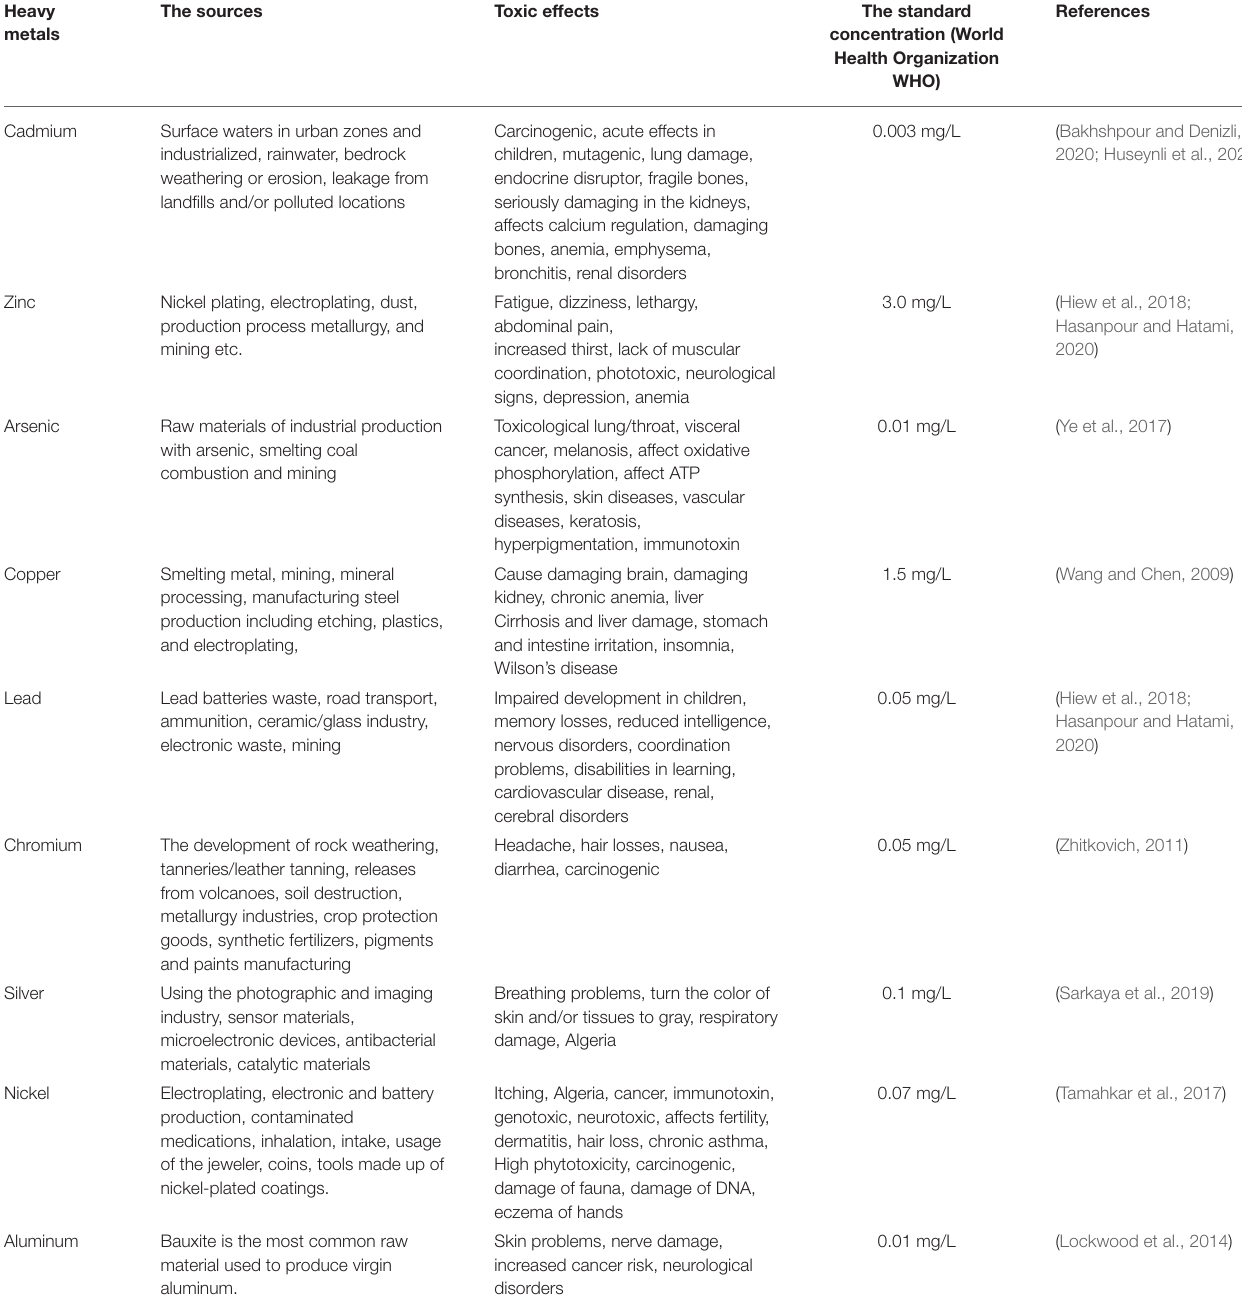
TABLE 2 | The summaries of the sources, toxic effects and the standard concentration of some heavy metals on human